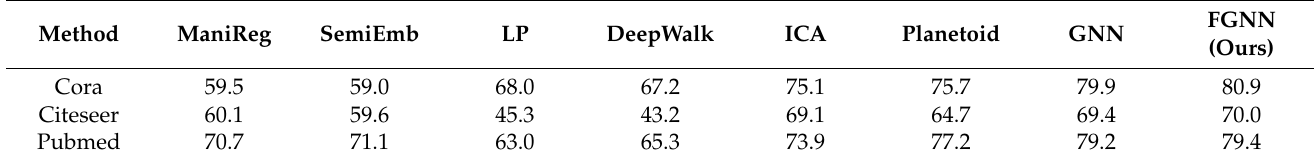
Table 5. Recognition accuracy (%) of the baseline models and FGNN on the citation network dataset Cora, Citeseer, and